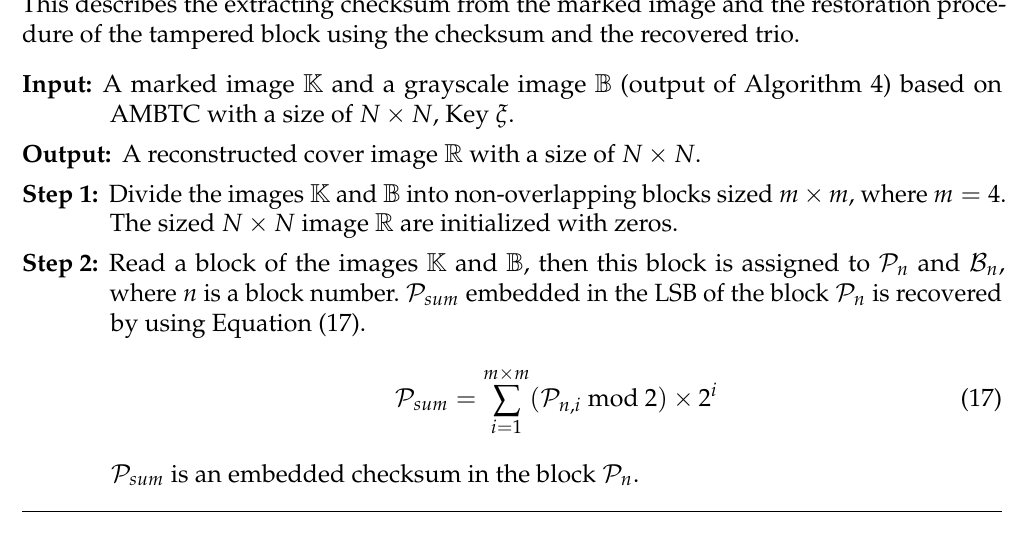
Algorithm 5 Watermark Authentication, Tamper Detection and Reconstruct Cover